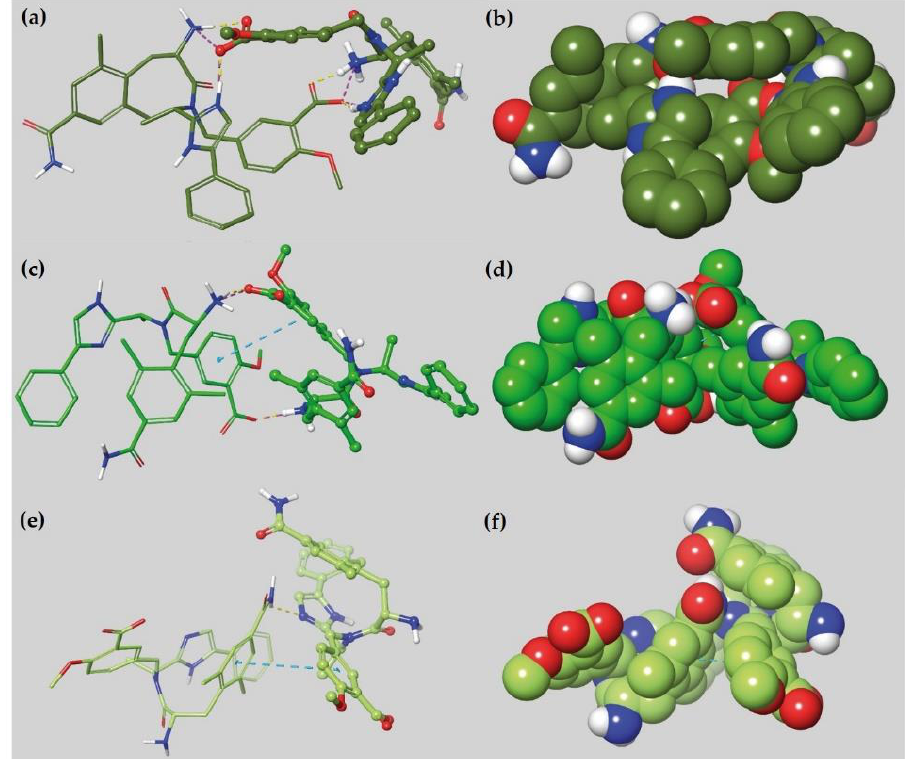
Figure 6. 3D representation of two molecules of E1 ( a , b ), E2 ( c , d ) and E3 ( e , f ) interacting during the MD simulations in water. H-bonds, salt bridges and π-π interactions were shown as yellow, magenta, and cyan dash lines, respectively.